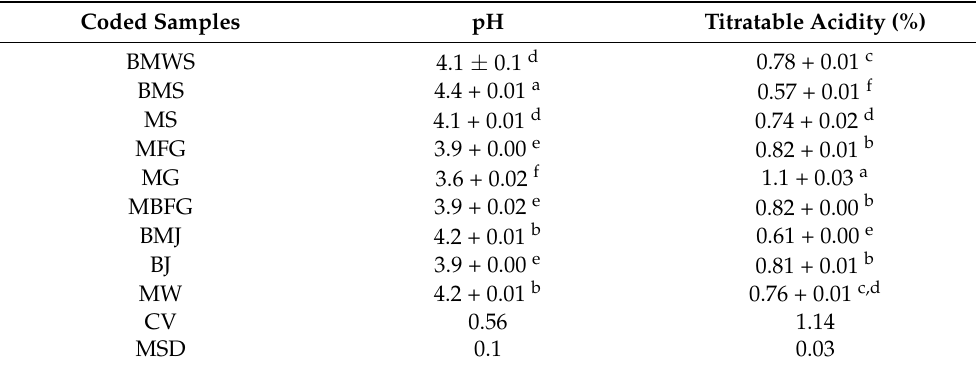
Table 2. Physicochemical properties (pH and TA) of Shameta samples collected from households of lactating mothers, East Wollega Zone, 2020. Coded